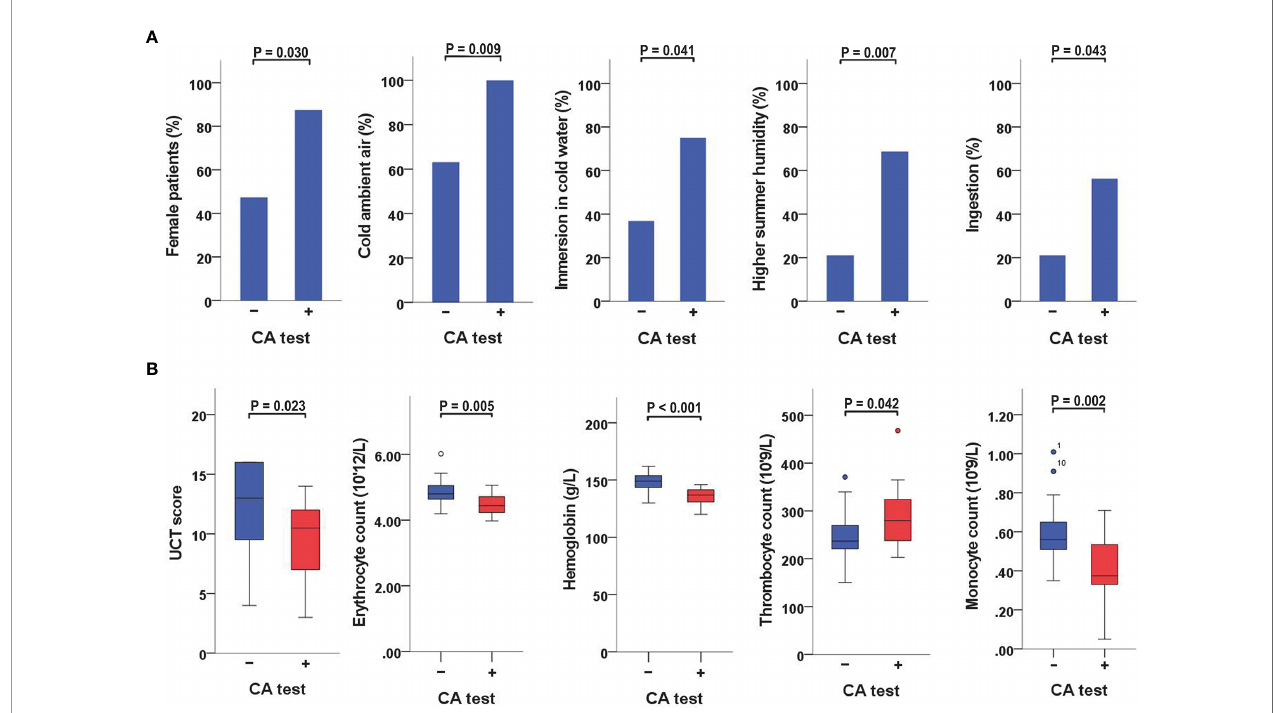
FIGURE 1 | Variables signi fi cantly linked to a positive CA-test (A) When CA-positive and CA-negative patients were compared, the former were more often female and had a higher rate of reactions triggered by cold ambient air or immersion in cold water, a higher rate of reactions aggravated by increased humidity levels in the summer, and a higher frequency of angioedema triggered by ingestion of cold foods or drinks. (B) When CA-positive and CA-negative patients were compared, the former also had lower UCT scores, lower erythrocyte counts, lower hemoglobin concentrations, higher thrombocyte counts, and lower monocyte counts. CA, cold agglutinin; UCT, Urticaria Control Test.